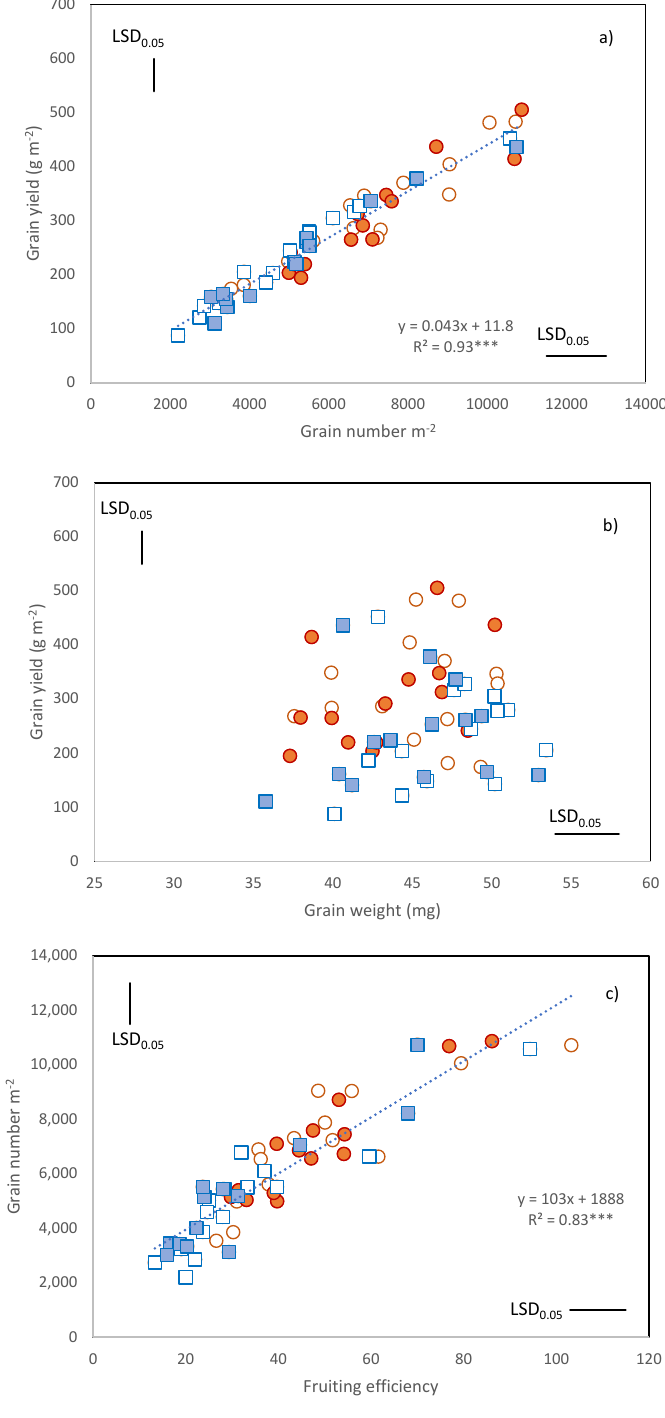
Figure 1. Relationships between ( a ) grain yield and grain m − 2 ; ( b ) grain yield and grain weight; ( c ) grain number m − 2 and fruiting efficiency. Data are C × Y × N means: orange circles, 2016; blue squares 2017; empty symbols, N46; filled symbols, N86. LSD 0.05 for the comparison of cultivar means within each Year × N combination. ***, Pearson correlation coefficient significant at p ≤ 0.001.